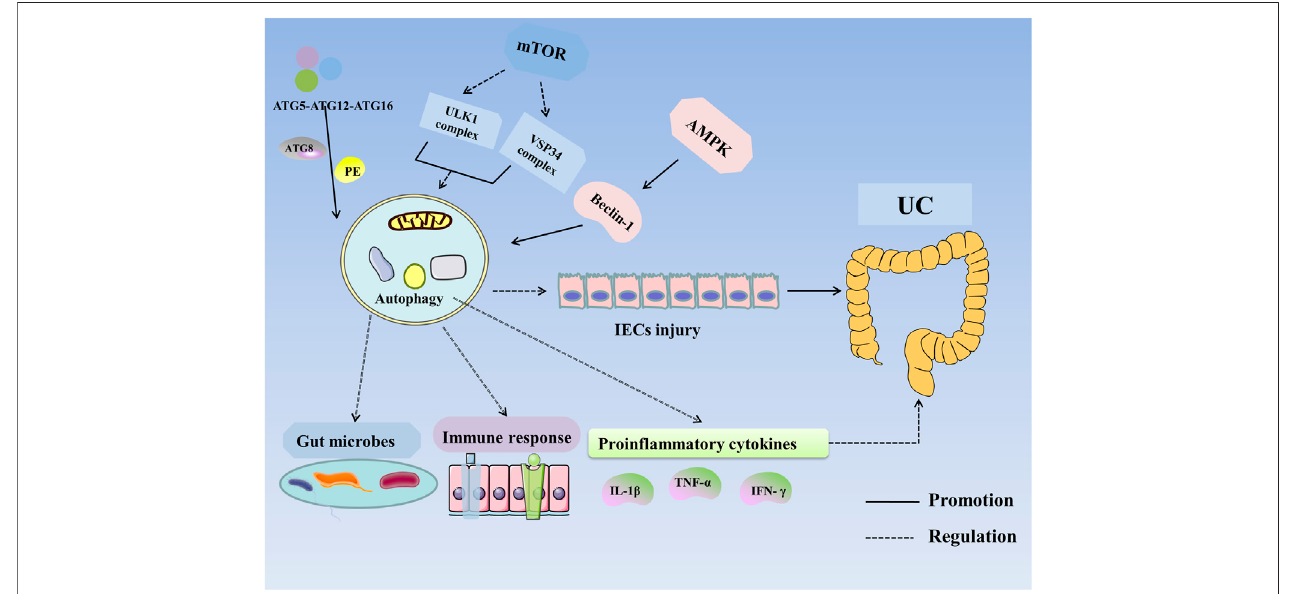
FIGURE 2 | Autophagy in UC. Autophagy is regulated by ATG, mTOR, AMPK, and NOD2. ATG participates in the formation of the ULK1 complex and initiates autophagy. The ATG12 – ATG5 – ATG16 complex recruits autophagosome membranes and combines ATG8 (LC3) with phosphatidylethanolamine (PE) to form an ATG8 – PE complex, leading to the formation of autophagosomes and autophagolysosomes. mTOR negatively regulates autophagy by inhibiting the ULK1 complex, VSP34 complex, and DAP1. AMPK activates ULK1 and phosphorylates Beclin-1 to activate autophagy. VDR enhances autophagy through Beclin-1. Autophagy improvesUCbyalteringtheexpressionofsusceptibility genes,improvingintestinalmicrobesandtheimmune responseand inhibitingtheexpressionofproin fl ammatory cytokines. Abbreviations: AMPK,5 ′ -monophosphate-activatedproteinkinase;ATG,autophagyassociatedgene;IECs,intestinalepithelialcells;IFN- γ ,Interferon- γ ;IL- 1 β , interleukin-1 β ; mTOR, mammalian target of rapamycin; PE, phosphatidylethanolamine; TNF- α , tumor necrosis factor- α ; UC, Ulcerative